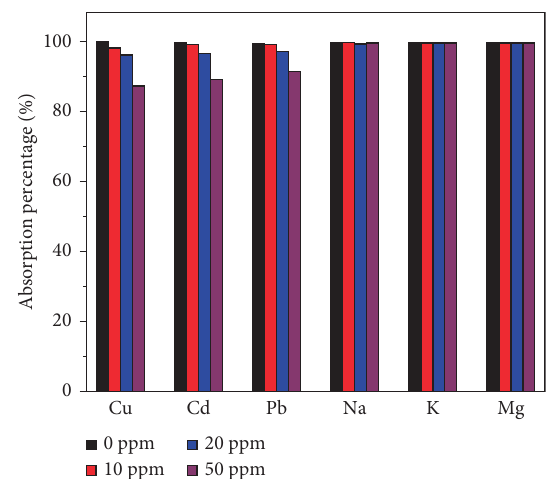
Figure 13: Effect of the competing anions on the GTNT